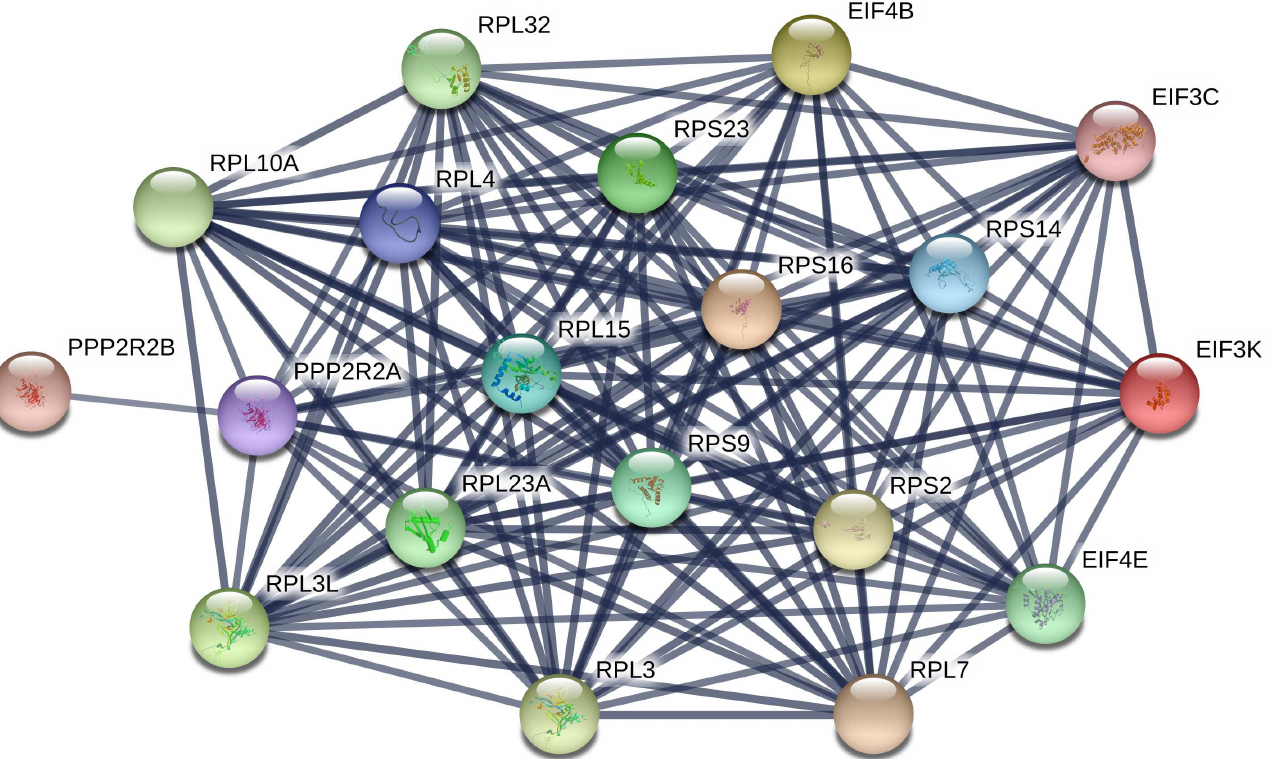
Fig 5. Network diagram of differentially expressed human EDM proteins in increasing severity of diabetes mellitus associated with both eIF2 and mTOR signaling pathways. This network indicates the close relationship of these protein groups. Network created using String database v10.5.